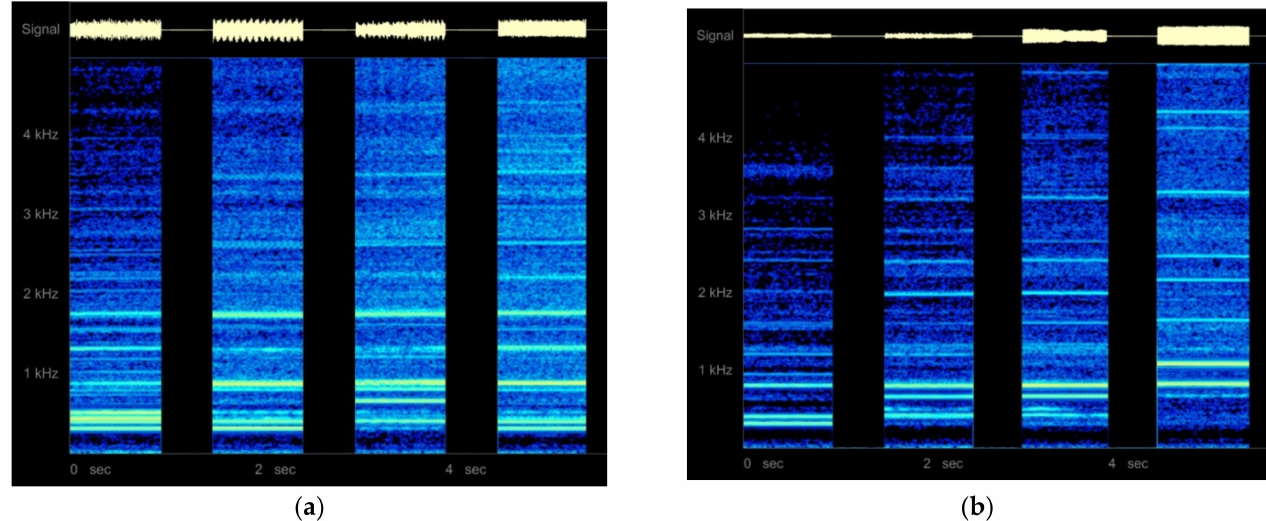
Figure 29. Spectrograms of quadruple flute experimental model “Anahuacalli 1”, all fingerholes stopped: ( a ) diagonal playing position to the right, different blowing pressures (1–3 gradually increasing, 4 overblown); ( b ) diagonal playing position to the left, different blowing pressures (1–3 gradually increasing, 4 overblown) (Sample